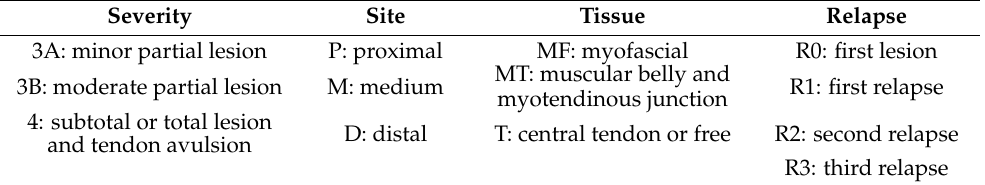
Table 1. Indirect structural muscle injuries classification (adapted from